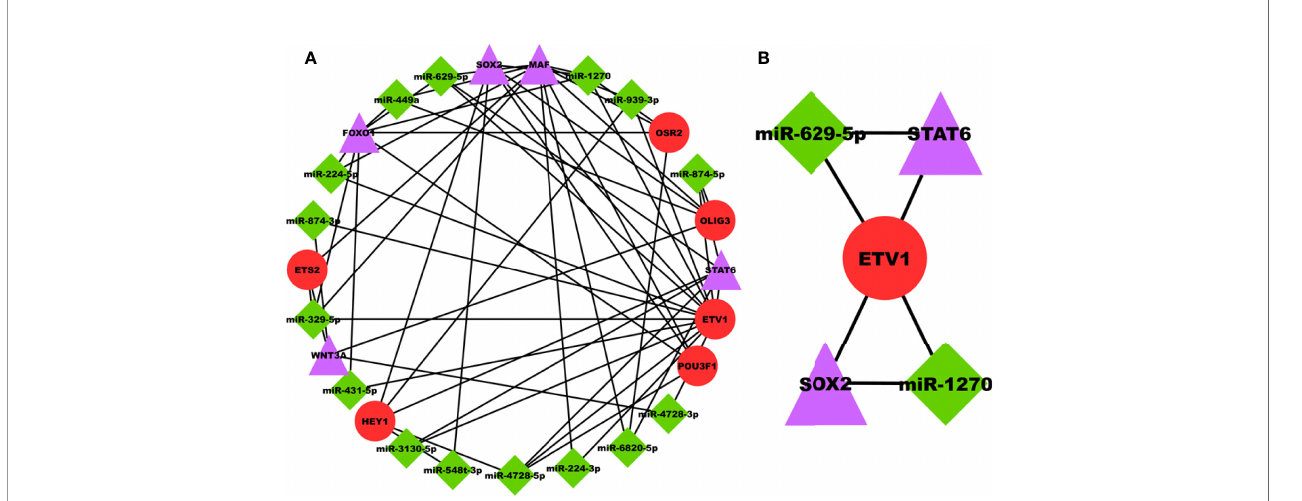
FIGURE 6 | (A) PRAD-speci fi c 3-node miRNA FFL network comprising 26 nodes and 58 edges. Red circular nodes represent TFs, green diamond nodes represent PRAD-speci fi c miRNAs, and magenta triangular nodes represent hub DEGs. (B) PRAD-speci fi c highest-order subnetwork FFL motif comprising one joint TF (ETV1), two miRNAs (miR-1270 and miR-629-5p), and two hub DEGs (SOX2 and